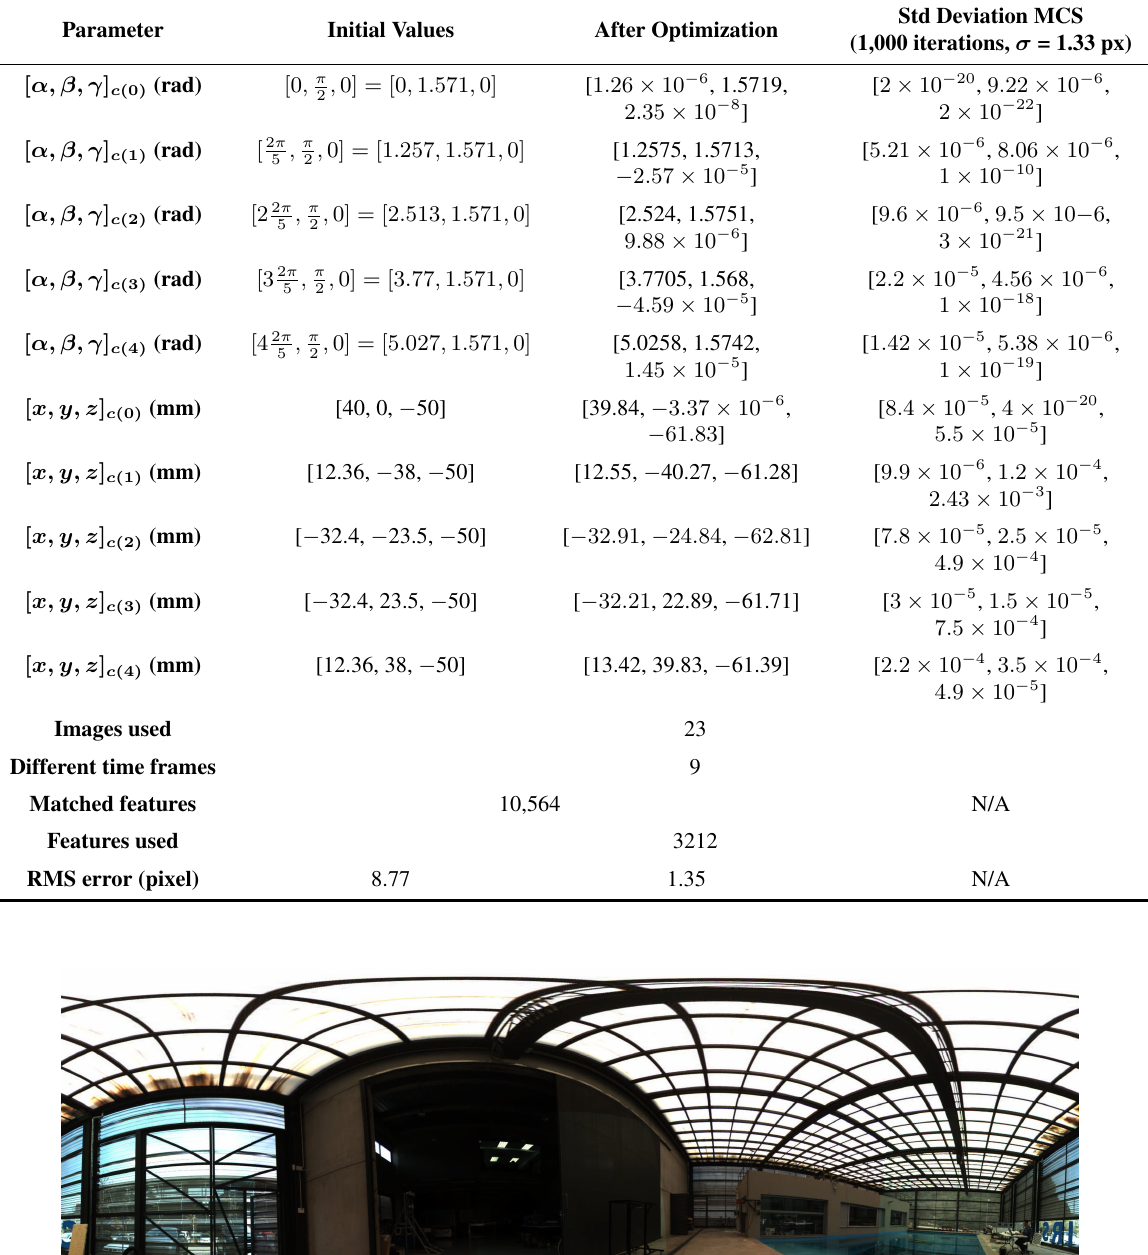
Table 4. Initial and refined values of the extrinsic parameter optimization and results of the Monte-Carlo Simulation (MCS). Camera 5 is selected as the global reference frame and, therefore, not included in the table.